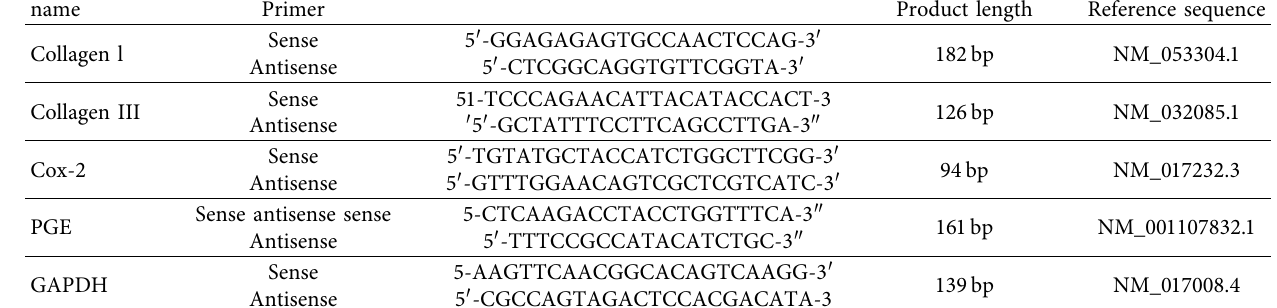
Table 1: Sequence list of 5 pairs of primers.